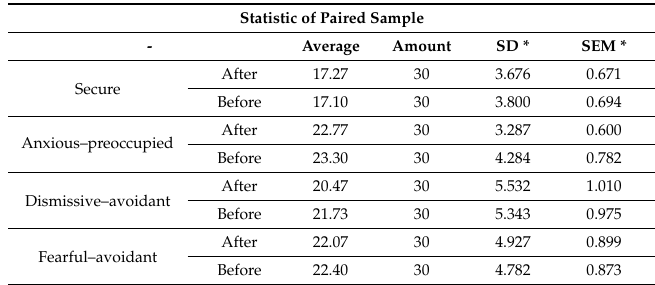
Table 5. Pre- and post-test for di ff erences in average values for attachment